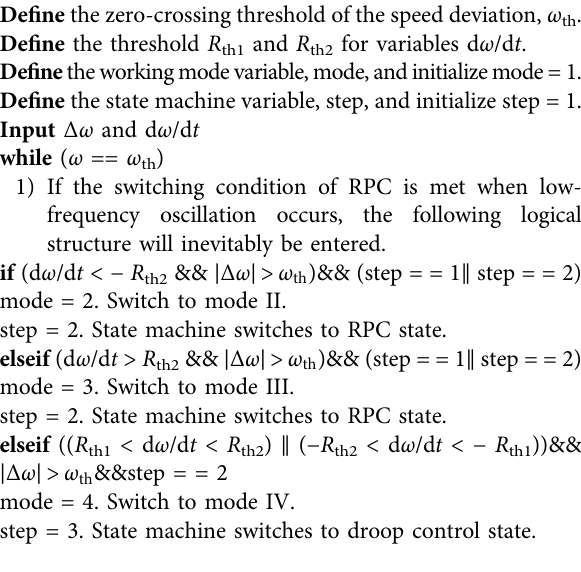
FIGURE 5 | Speed of SG and the compensation power of VSC2.